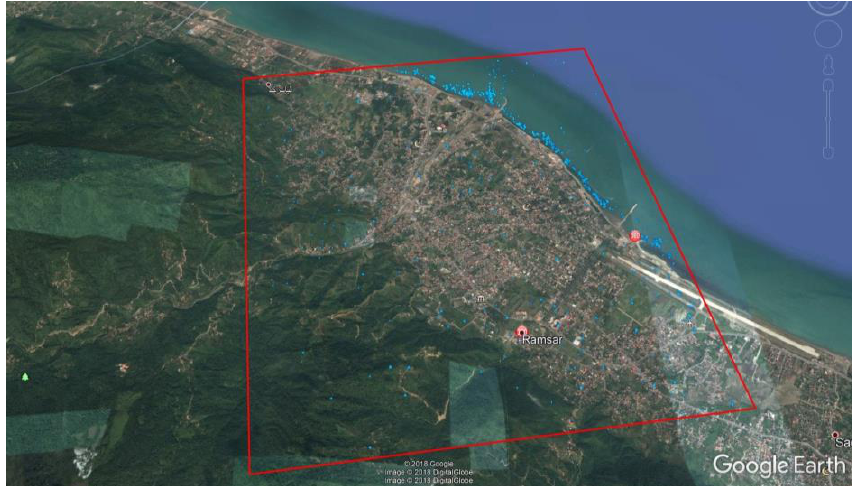
Figure 7. Flooded areas in Ramsar based on the change detection in Google Earth Pro processed in SARPROZ in